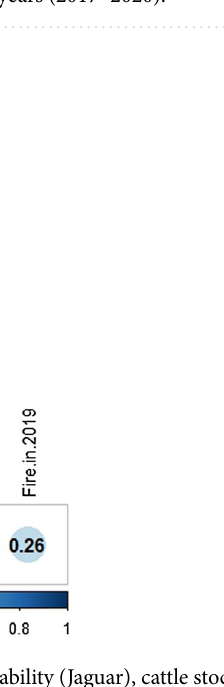
(v. 3.16.5; QGIS Development Team 2021). ( B ) Pearson correlation coefficient between habitat suitability for jaguars and the areas affected by wildfires in the last four years (2017–2020).